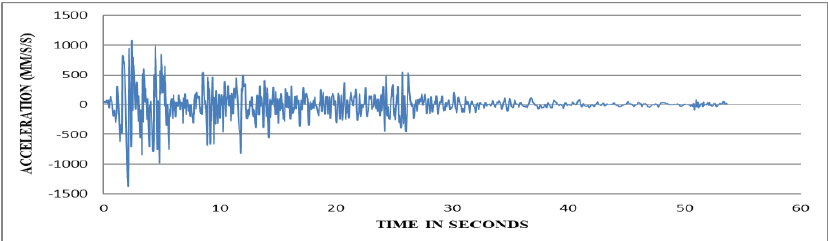
Figure 5. Vibration of 0.4 g El Centro 1940 NS Earthquake excitation input to the shake table.